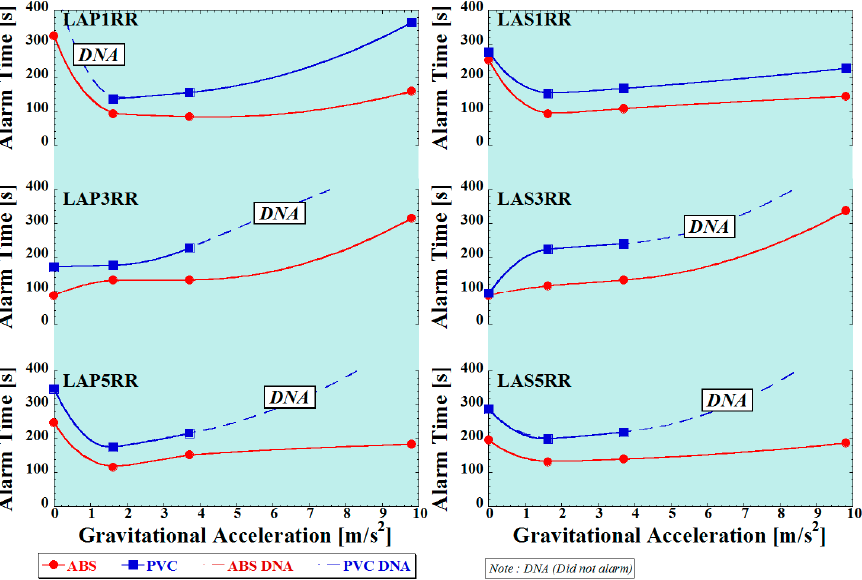
Figure 12. Detection time with respect to the gravity field environment of the smoke detector inside the Destiny module without IMV flow.